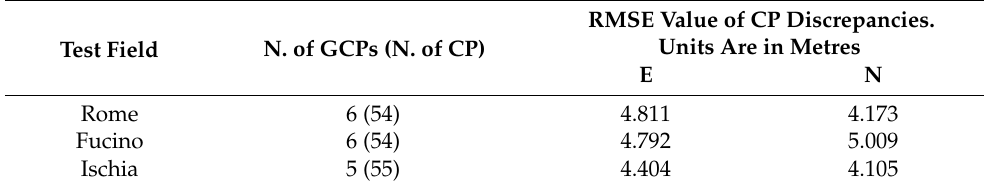
Figure 11. Accuracy trend as a function of RPC coefficients—test field Rome ( a ), Fucino ( b ) and Ischia ( c ). Table 11. Maximum accuracy achieved.